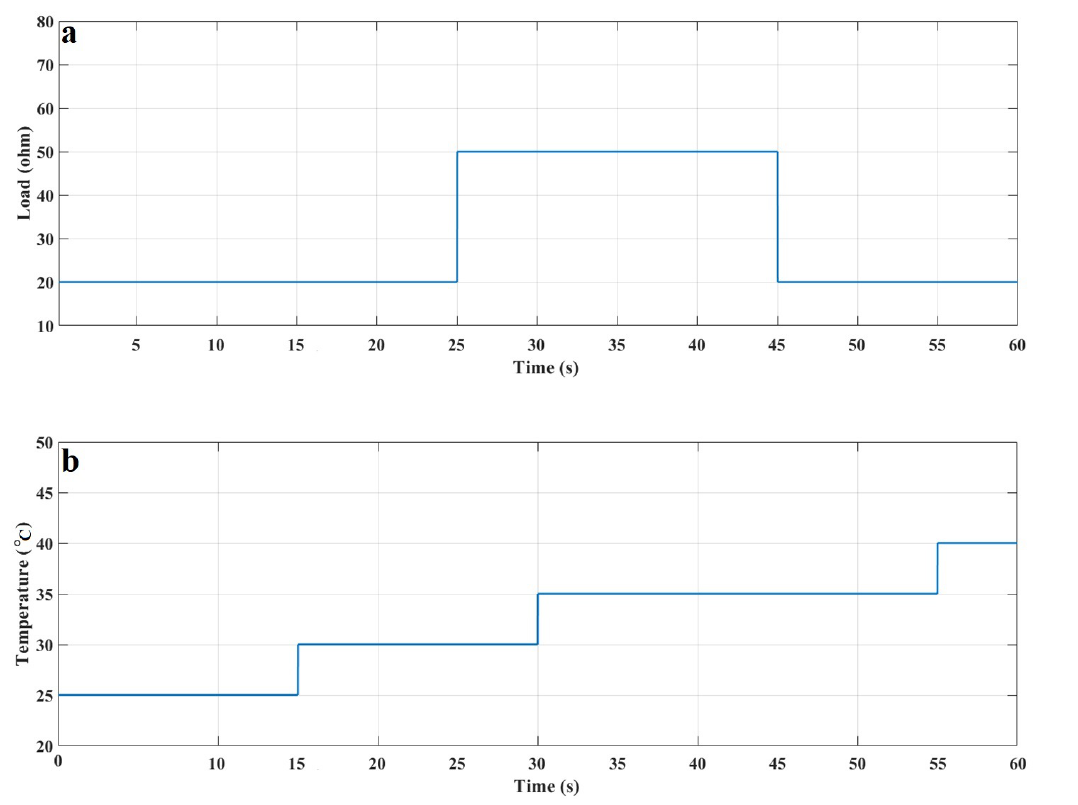
Figure 10. ( a ) Resistance; ( b )